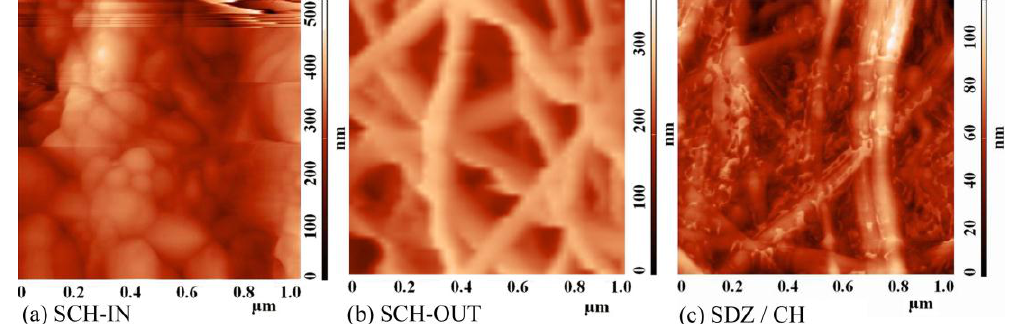
Figure 4. Atomic Force Microscopy (AFM) images of ( a ) SCH-IN; ( b ) SCH-OUT and ( c ) SDZ/CH samples (scanned area 1 μm × 1 μm).